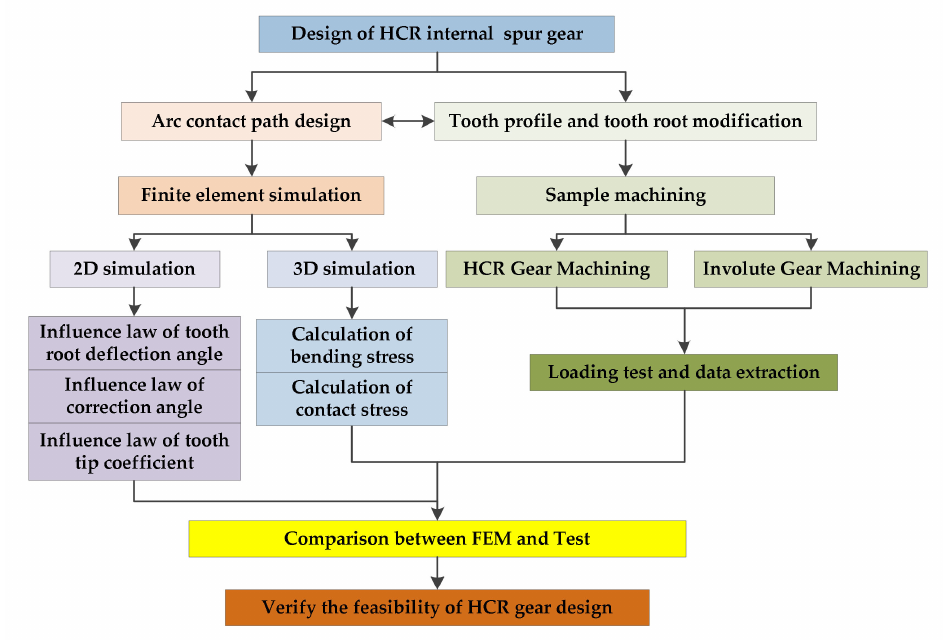
Figure 4. The main process of this paper.